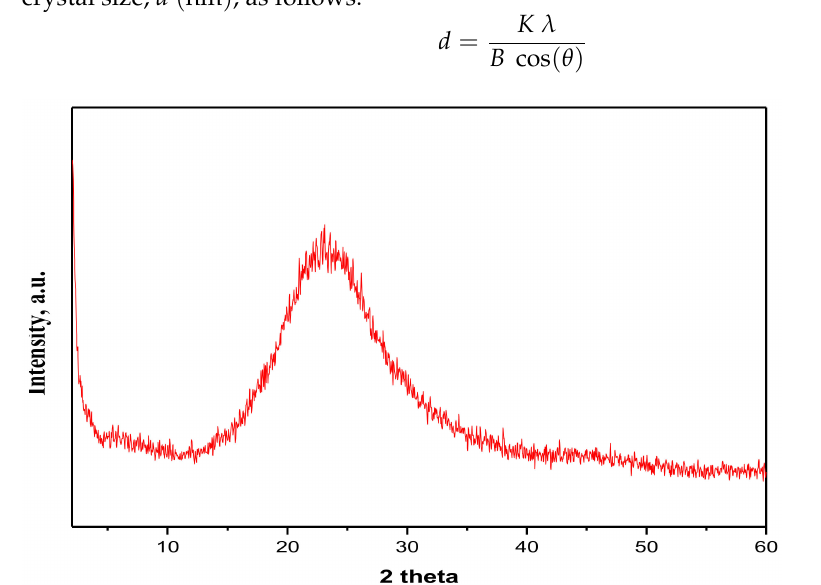
Figure 1. XRD pattern for the produced nanosilica from a sol–gel